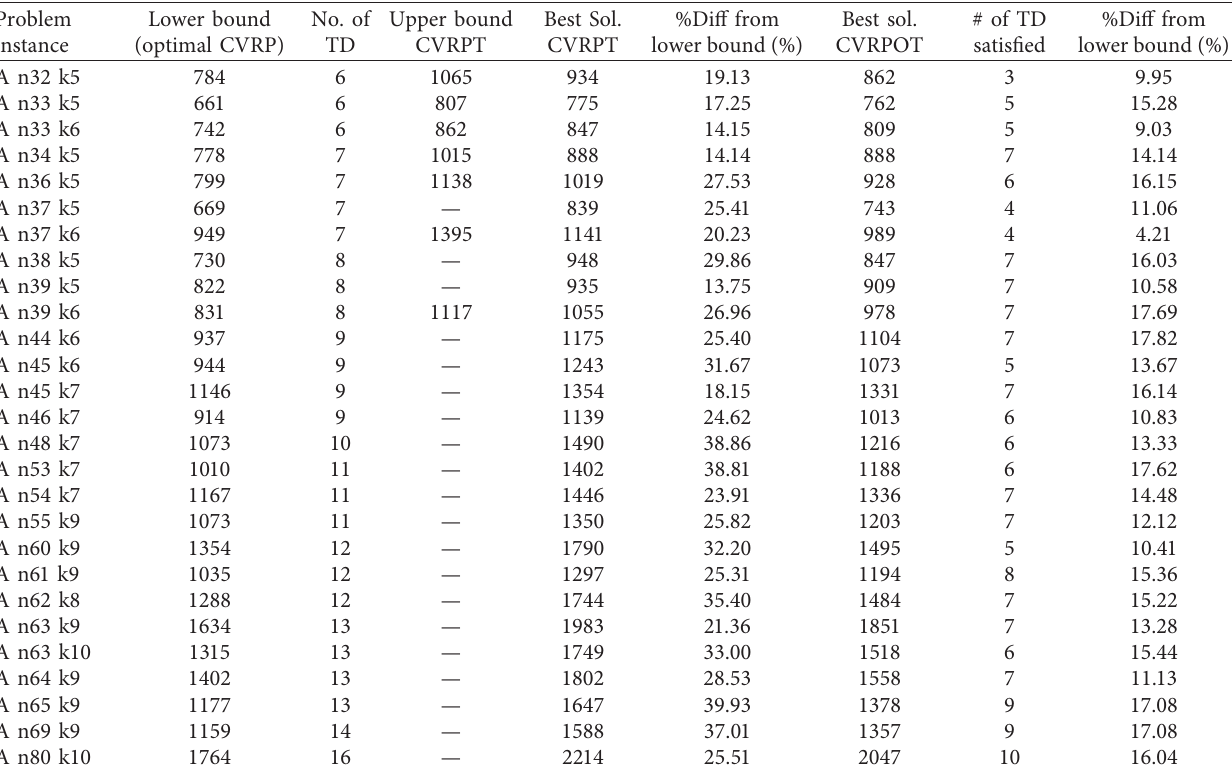
Table 5: Comparison between the best-found solutions from TA-NS and the lower bound (optimal solution of VRP) of set A.